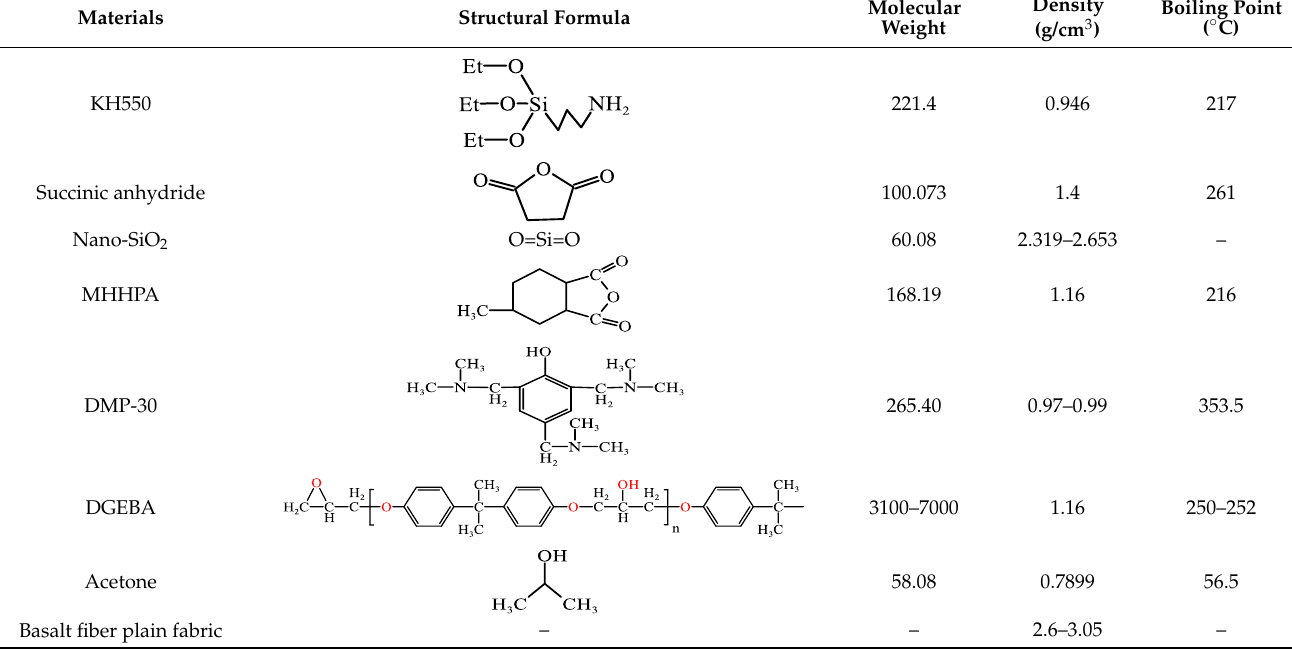
Table 1. Physical and chemical properties of experimental materials.